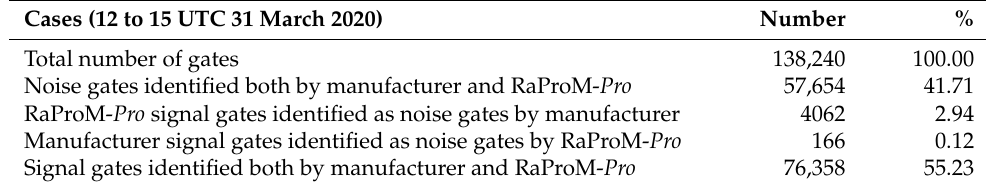
Table A1. Signal and noise gates detected by manufacturer versus RaProM- Pro methods.